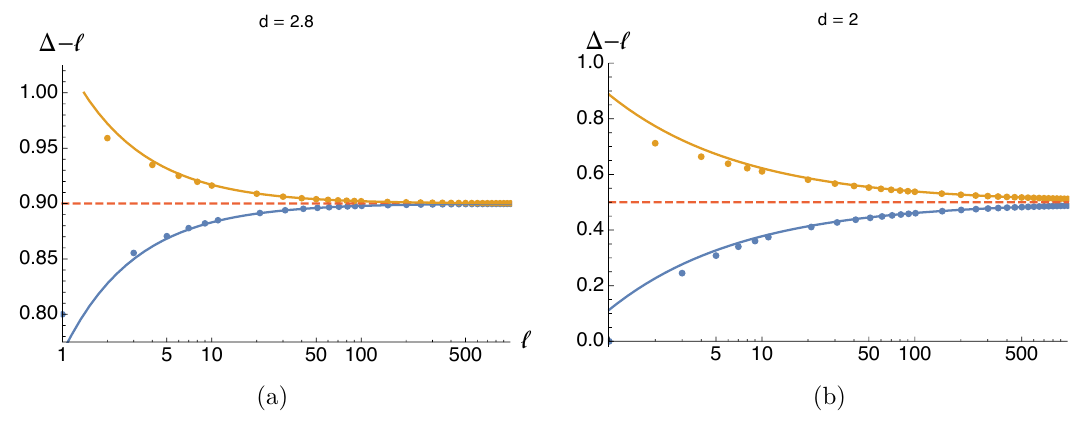
Figure 10 . Twist of the first two families of singlet bilinear operators as a function of the spin ‘ for two different values of spacetime d . The two families correspond to spin odd (blue) and spin even (yellow). The dots represents numerical solutions of the eigenvalue equation (3.27). We did not report all spins. The continuous lines show the leading correction given in (3.42). The dots for ‘ = 1 correspond to the supermultiplet of the stress